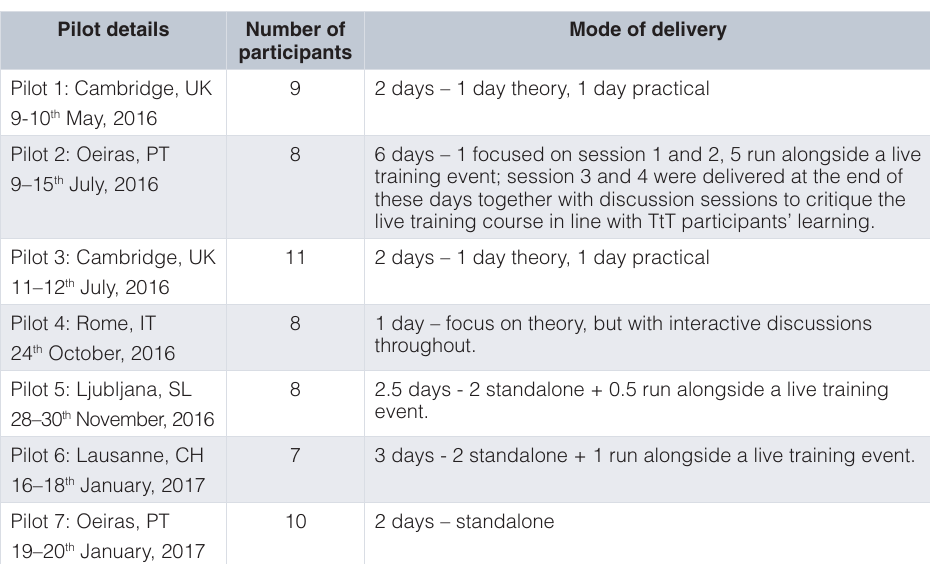
Table 2. EE-TtT pilot courses. EE-TtT pilot courses were delivered using two main models: 1) standalone courses lasting one or two days; 2) courses including at least one additional session in which learners sit in on a live training event as observers and/or helpers. Afterwards, trainers and trainees sit together to discuss what they saw in the live classroom and what impact that may have on their own